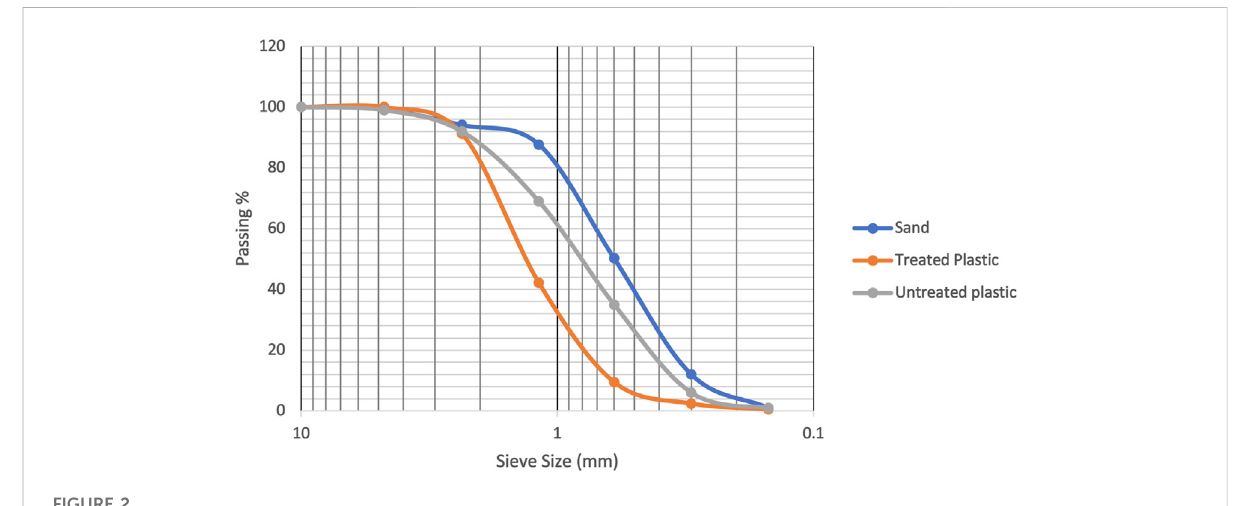
FIGURE 2 Grading of sand and PET particles.